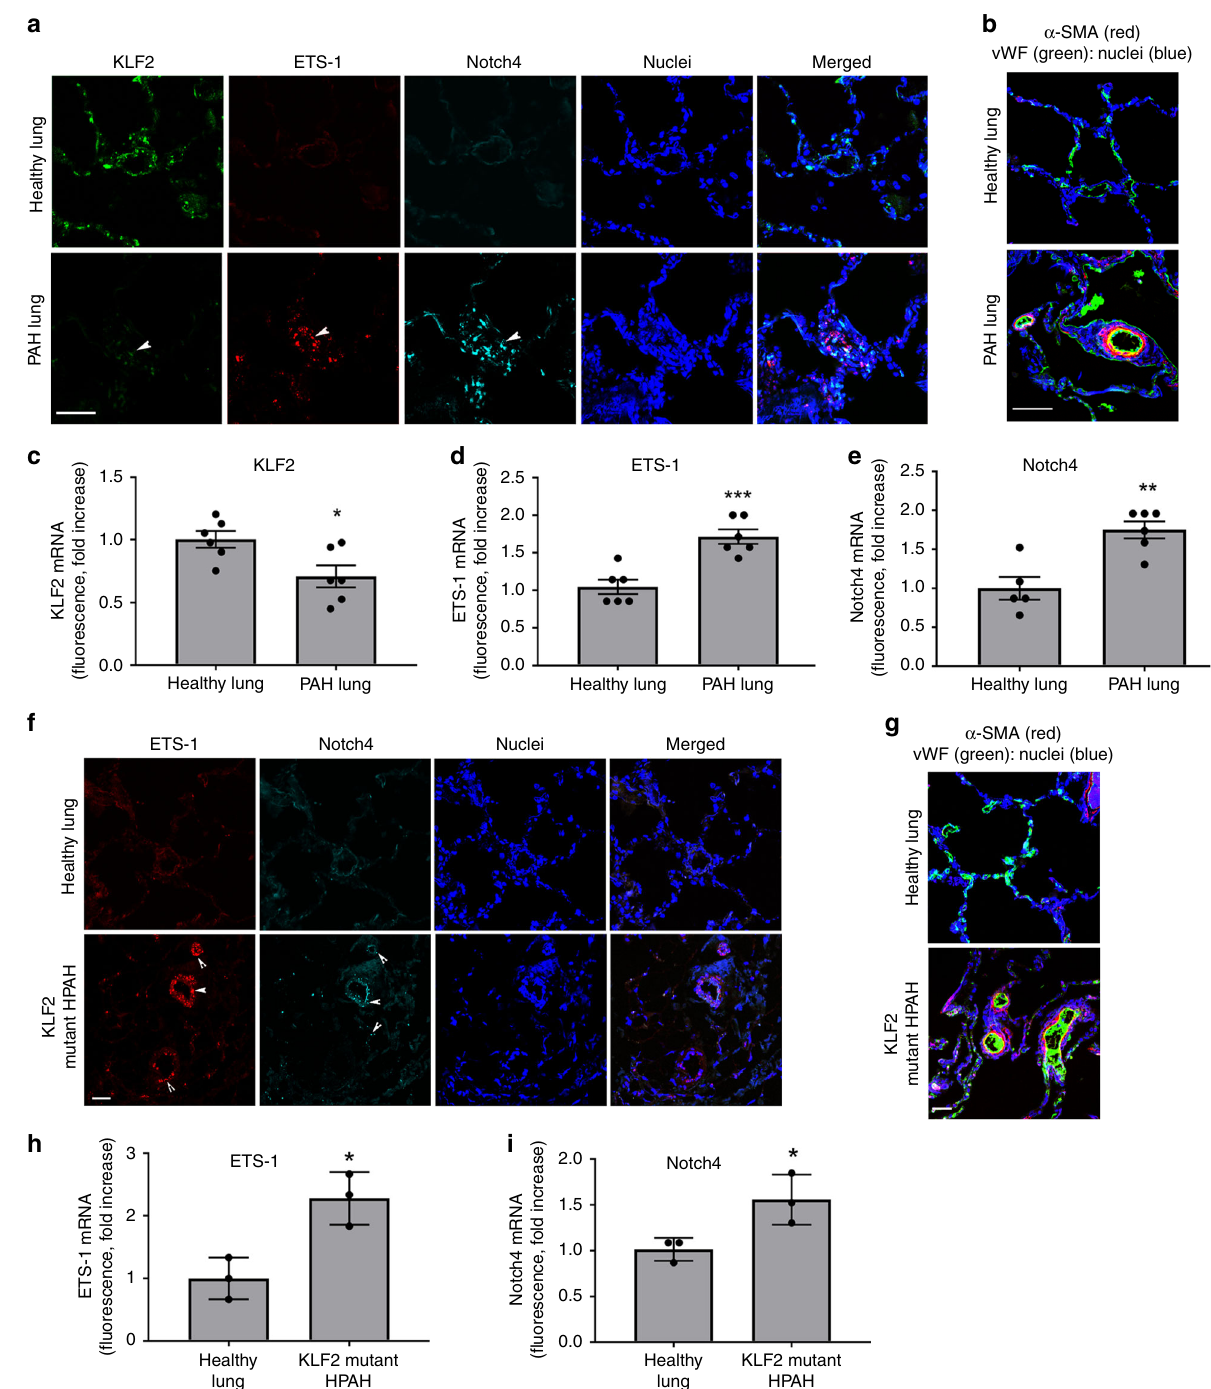
Fig. 7 KLF2, ETS-1 and Notch4 mRNA levels in lung tissues of PAH patients. a Representative images of KLF2, ETS-1 and Notch4 mRNA distribution in healthy and PAH lung; RNAscope fl uorescent in situ hybridisation. b α -SMA and vWF staining in healthy and PAH lung. In a , b , bar = 50 µ m. c – e Graphs showing KLF2, ETS-1, and Notch4 mRNA levels in healthy and PAH lung tissues; n = 6. f Representative images of ETS-1 and Notch4 mRNA expression in healthy lung and lungs from HPAH patients with disabling KLF2 mutation. g α -SMA and vWF staining in healthy and HPAH lung. In f , g bar = 25 µ m. h , i graphs showing ETS-1 and Notch4 levels in healthy lung tissues and lung tissues from HPAH patients with KLF2 mutation, n = 3. In c – i values are mean fold-changes of controls ± s.e.m. * P < 0.05, ** P < 0.01, *** P < 0.001, comparison with healthy controls; unpaired t -test. All n numbers are biologically independent samples. Source data are provided in Source Data fi